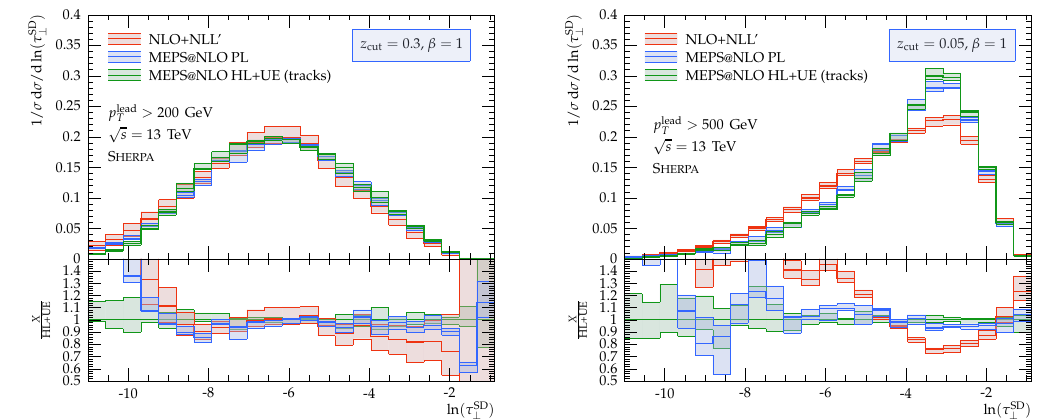
Figure 17 . The groomed transverse-thrust distributions for events with a leading-jet transverse momentum p lead > 200 GeV, with z cut = 0 . 3 and β = 1 (left) and p lead T and β = 1 (right). Shown are results at NLO + NLL 0 accuracy as well as MEPS @ NLO predictions obtained with S HERPA at parton level (PL), full hadron level (HL+UE), the latter based on charged tracks with p track > 500 MeV. In all cases we only include final-state particles with | y | < 2 . 6 in T